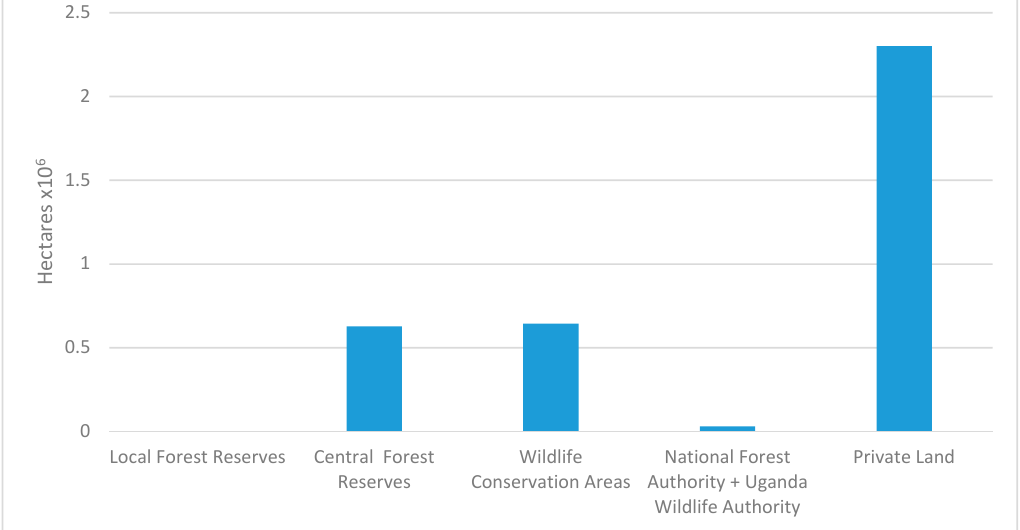
Figure 1. Forest area in Uganda.